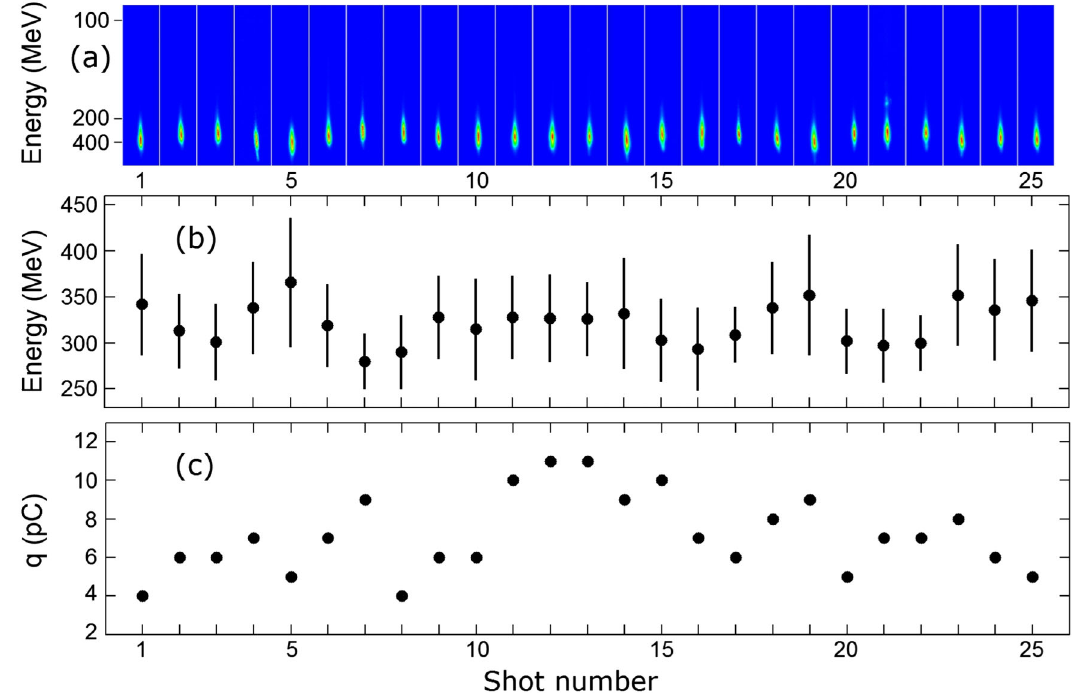
FIG. 7. (a) LANEX images of magnetically dispersed beams for 25 consecutive shots taken at n e ¼ 6 (cid:2) 10 18 cm (cid:3) 3 and P ¼ 55 TW ; the color scale is normalized for each shot. In all cases, the low-energy tail is not detected at all. The beam pointing fluctuation for this series of shots is (cid:4) 1 mrad . (b) Electron energy corresponding to the spectral peak (markers) and FWHM energy spread (bars) vs shot number. (c) Integrated charge, taking into account background noise on the